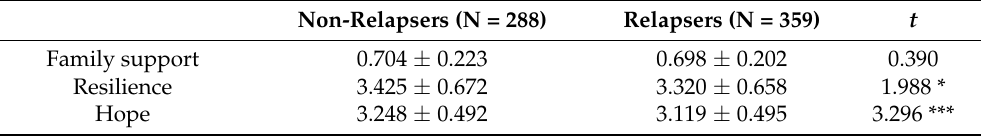
Table 2. The t -test of family support, resilience, and hope of non-relapsers and relapsers.